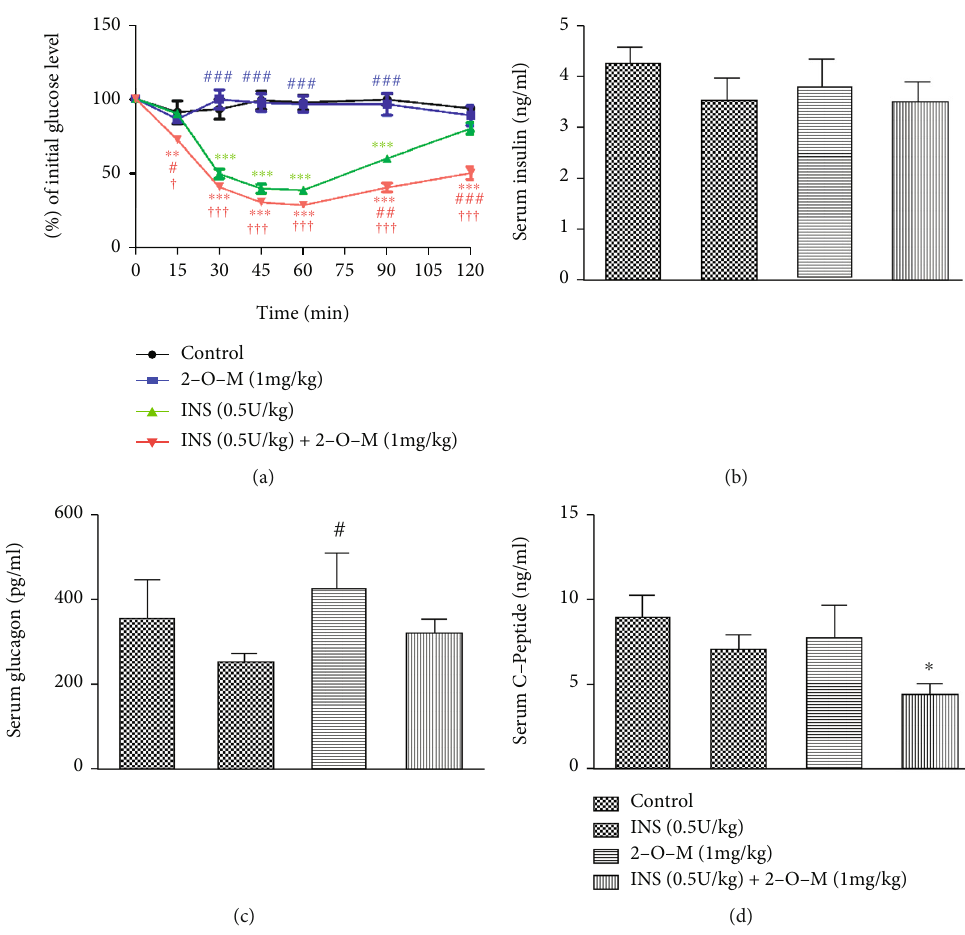
Figure 3: 2 ′ -O-Methylperlatolic acid (2-O-M) enhances the insulin-activated hypoglycemic e ff ect in mice with STZ-induced diabetes. (a) Blood glucose change within 120 minutes. (b) Serum insulin level at 120 minutes. (c) Serum glucagon level at 120 minutes. (d) Serum C- peptide level at 120 minutes. Data are shown as the mean ± SEM ( n = 4 – 8 in each group). ∗ p < 0 : 05 ; ∗∗ p < 0 : 01 ; ∗∗∗ p < 0 : 001 versus control. # p < 0 : 05 ; ## p < 0 : 01 ; ### p < 0 : 001 versus